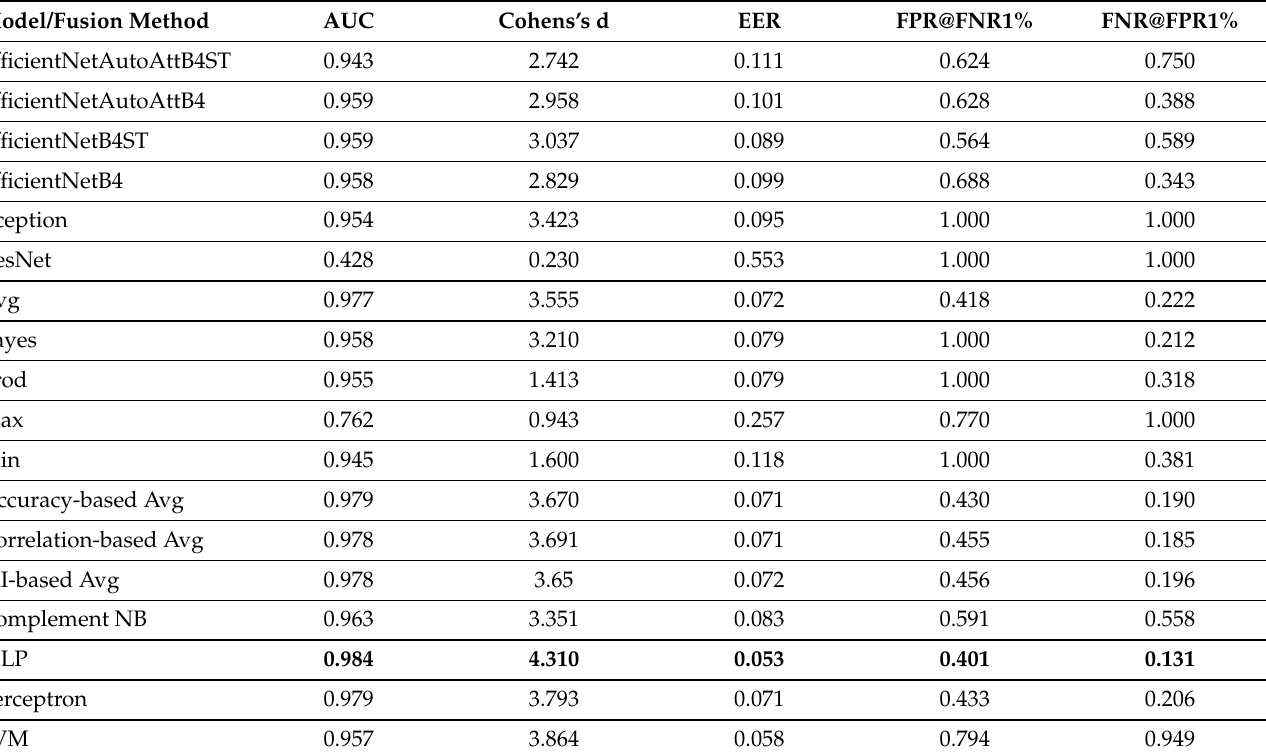
Table 2. The results on the FF++ in the intra-dataset scenario (the best values related to each performance metric are reported in